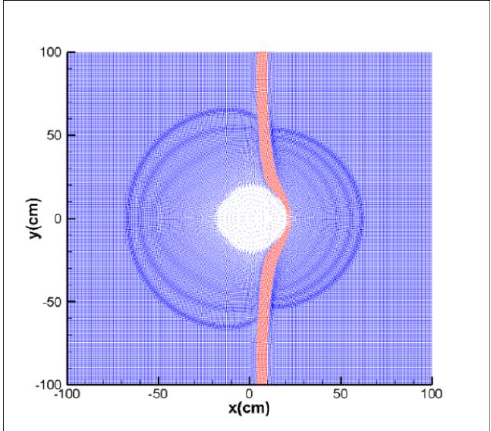
Figure 4. Particles distribution at the end time (example 1).